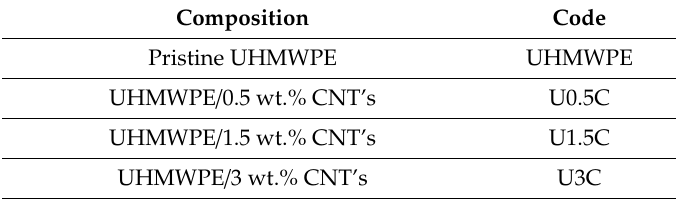
Table 1. Codes assigned to each of the compositions prepared in the present